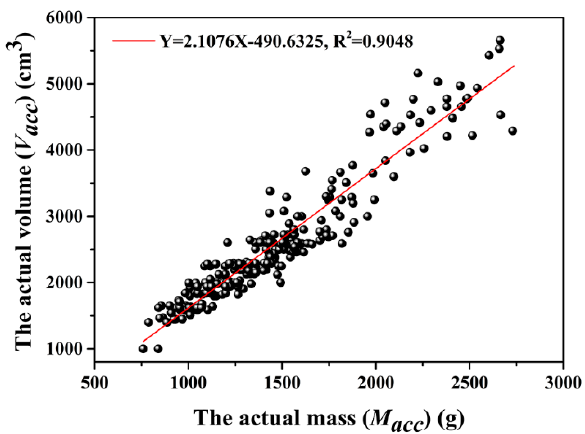
Figure 8. Linear fitting analysis of the actual mass ( Macc ) as weighed with a balance and the actual volume ( Vacc ) as measured using WDM.